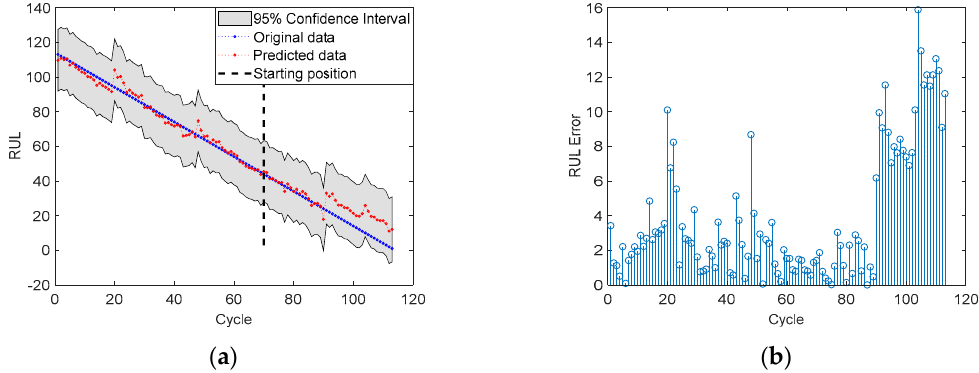
Figure 15. RUL prediction results for battery No. 6 with SP = 71: ( a ) RUL; ( b ) RUL prediction Error.